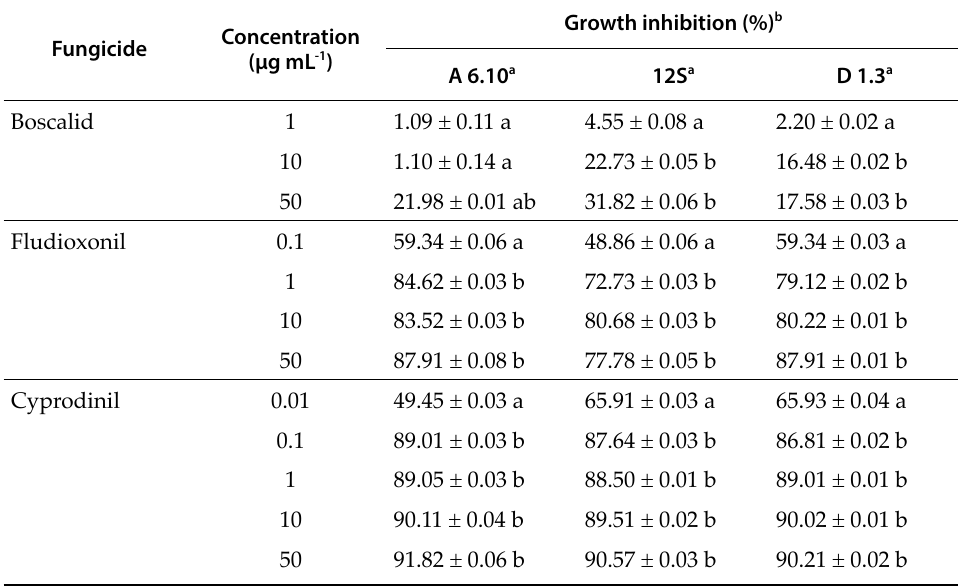
Table 2. Mean colony radial growth inhibition (%) for the fungicides fludioxonil, cyprodinil or boscalid at different concen - trations for three toxigenic Aspergillus flavus strains.